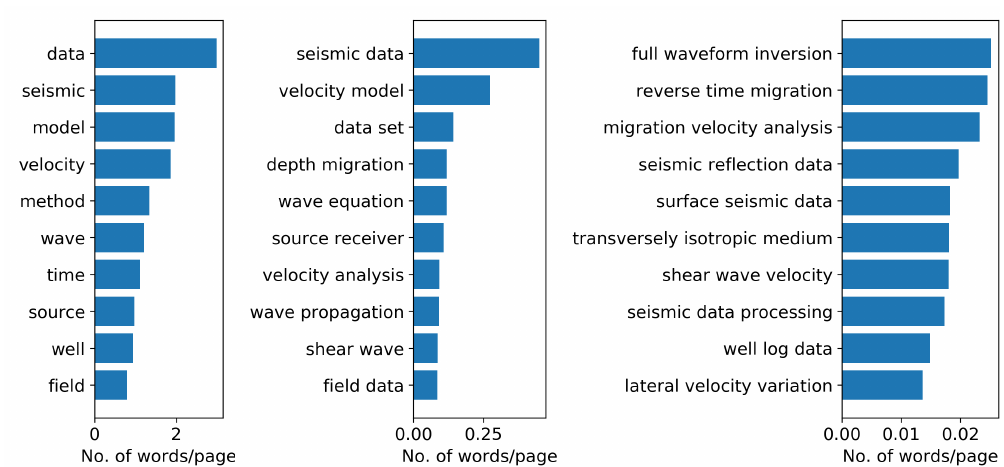
Figure 2. The average frequency of sigrams ( left ), bigrams (middle), and trigrams ( right ) per page